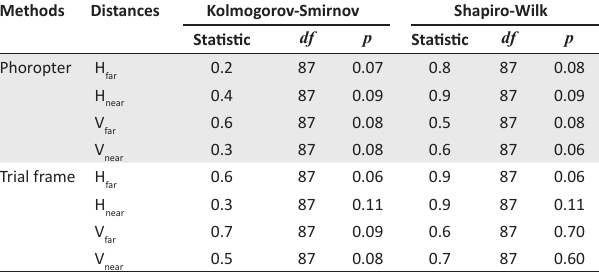
TABLE 1: Tests of normality for Von Graefe heterophoria in 88 adults, aged 18–39 years, using the Kolmogorov-Smirnov and Shapiro-Wilk tests. Methods